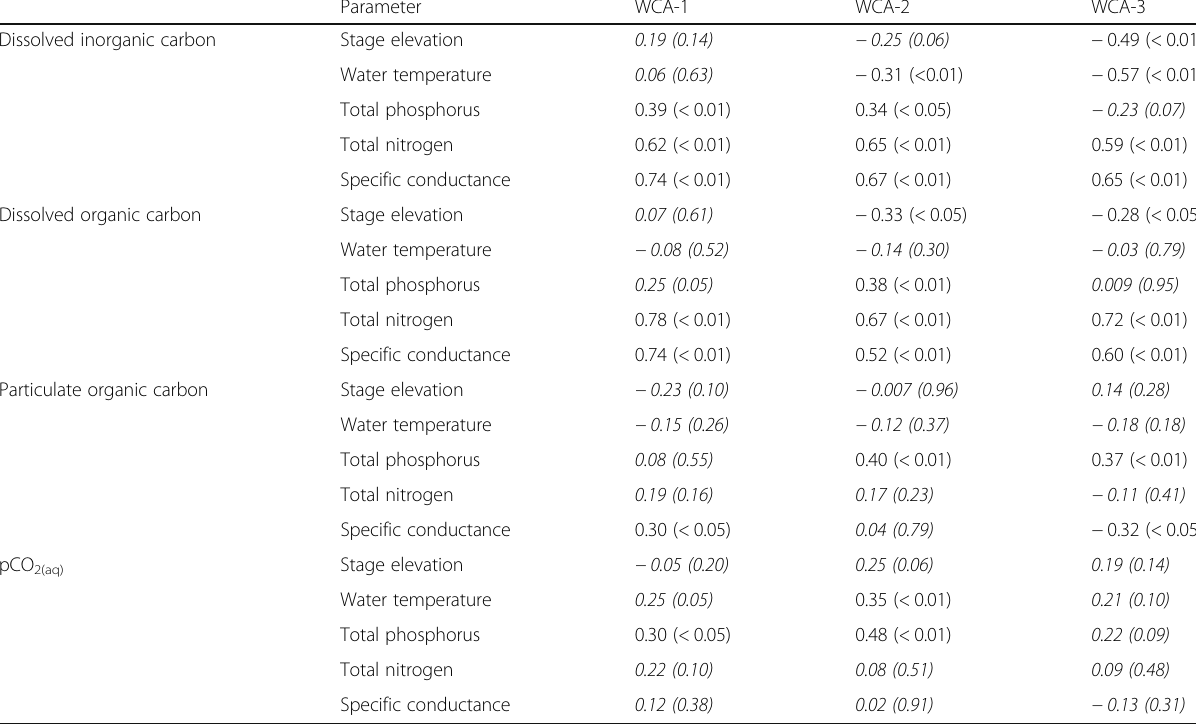
Table 4 Spearman correlation analysis results of monthly mean surface water carbon variables and various water quality